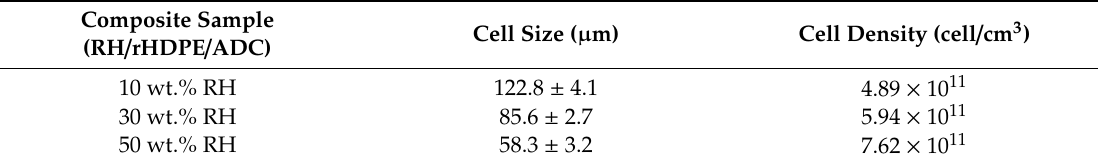
Table 1. E ff ect of rice husk loading on the cell size and cell density of RH / rHDPE composite